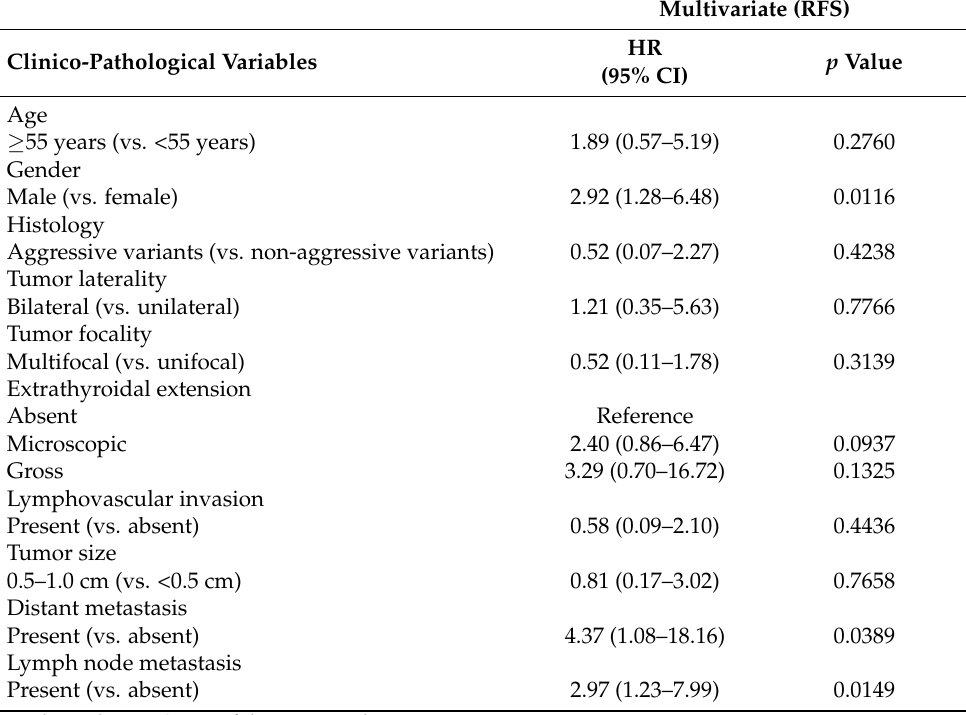
Table 4. Multivariate analysis using a Cox proportional hazards model for predictors of recurrence- free survival (RFS) in